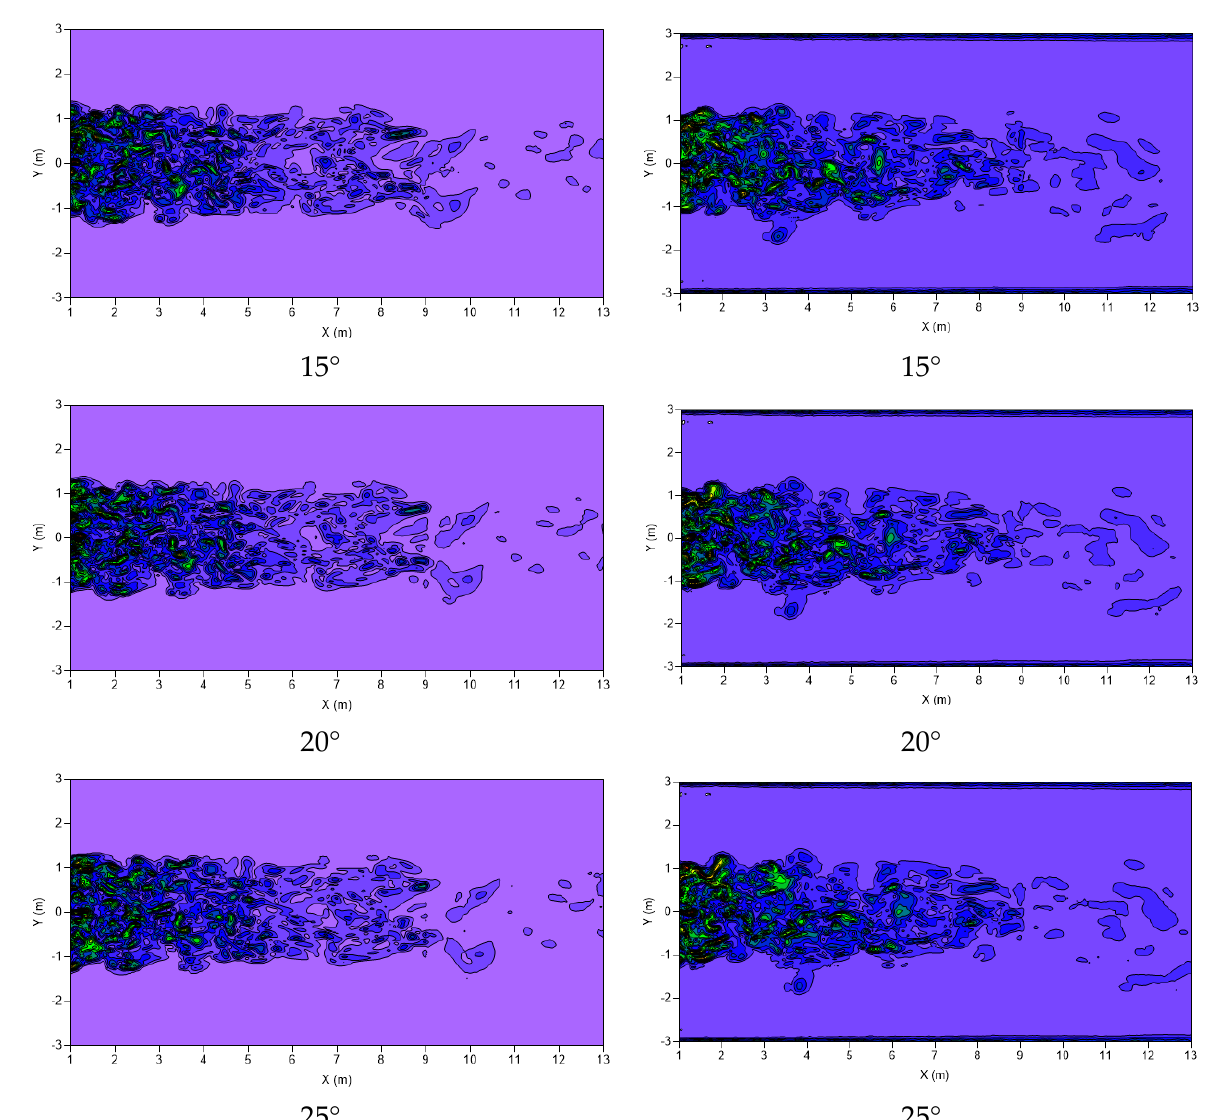
Figure 10. Spatial distribution of vorticity magnitude (in %) in the wake region of healthy and damaged VAWTs.